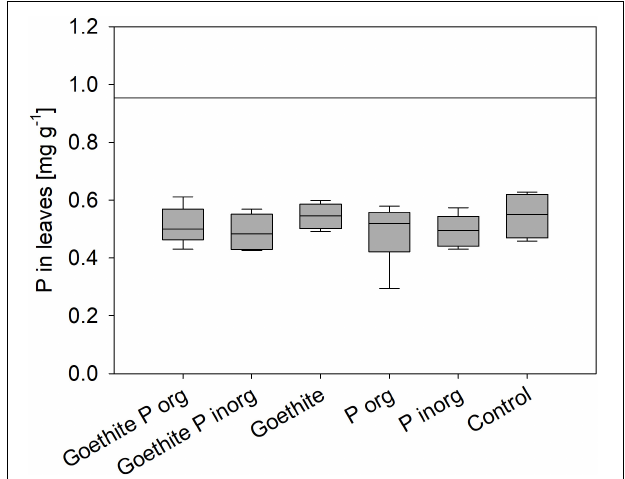
FIGURE 3 | Phosphorus content of leaves at the end of the experiment; error bars represent standard errors; no statistical differences between treatments were detected. Black line represents threshold value for P deficiency symptoms (Göttlein,